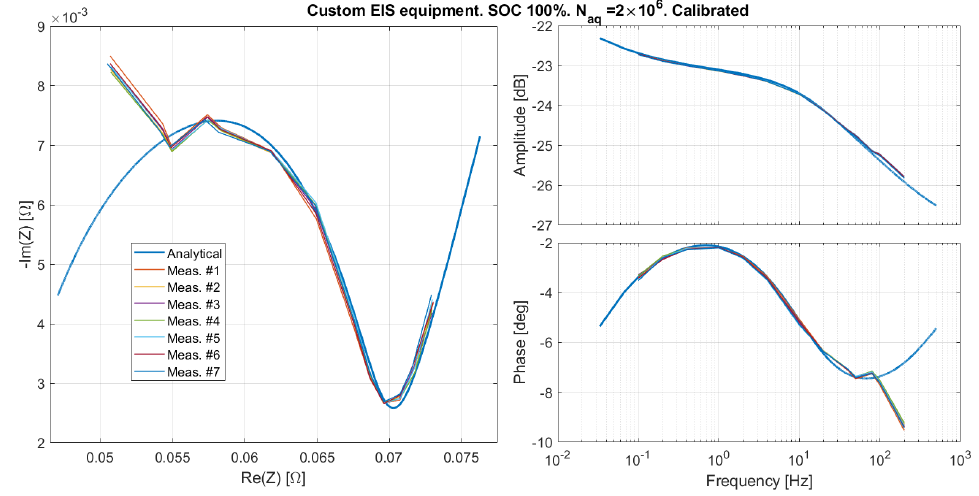
Figure 11. The emulated impedance as measured by the custom EIS measurement system after the calibration illustrated in Section